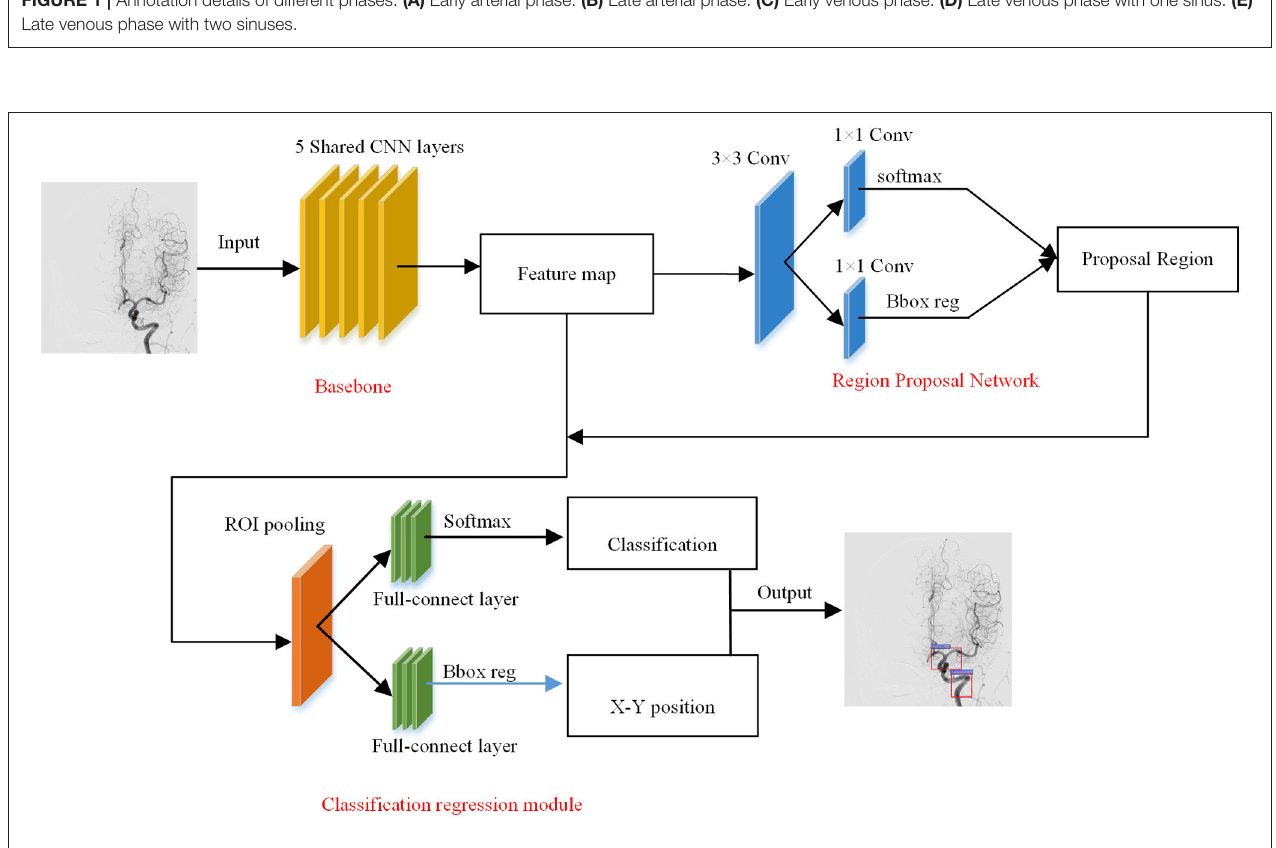
FIGURE 2 | The structure of Faster-RCNN network.